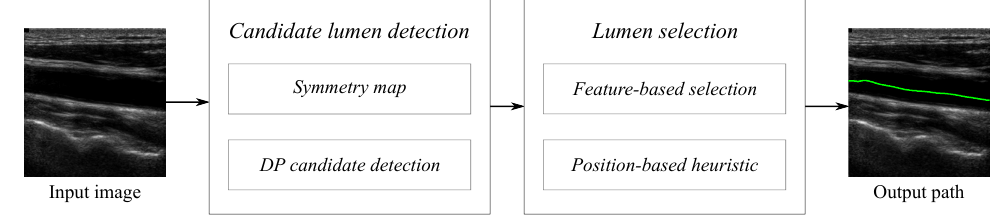
Figure 1. Diagram of the different stages in the proposed automatic lumen detection